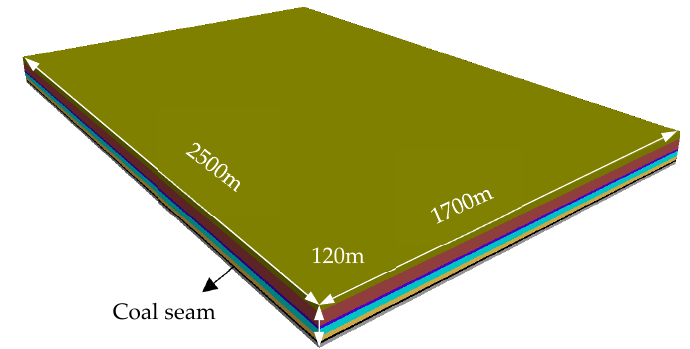
Figure 9. Numerical model for simulation. The black group is the coal seam.